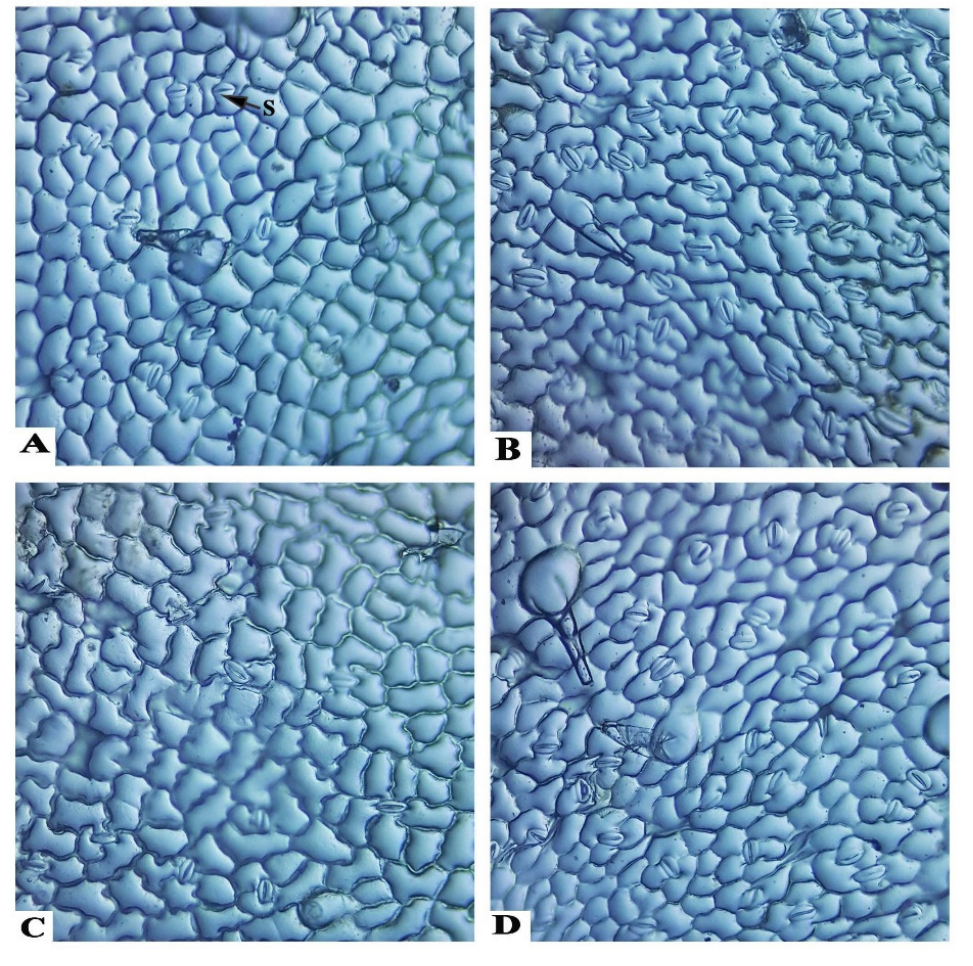
Figure 4. Photographs of stomata on adaxial (upper) surfaces of the tomato leaves, as affected by the application of various concentrations of PBZ substance, 10 days after applications, where ( A – D ) represent the treatments of the control, applied PBZ at 25, 50, and 100 mg L − 1 . The abbreviation: S, stomata.